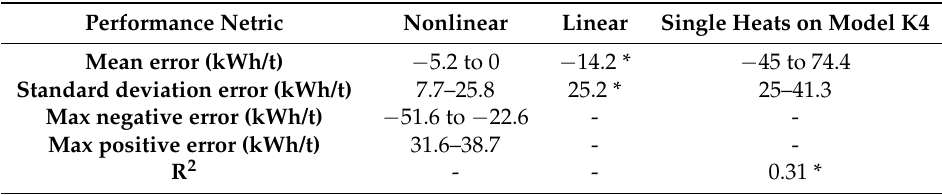
Table 7. Performance metric value spans for linear and nonlinear models that have been tested on future single heats from the same furnace. The models were A, B, C, D, E from the first study by Baumert et al. [47], and D from the second study by Baumert et al. [48,49]. See Table 6. Köhle’s model with energy loss, K4, is the only model where single heats from other furnaces has been applied. It was included in a separate column due to its frequent usage in literature. * Only one reported